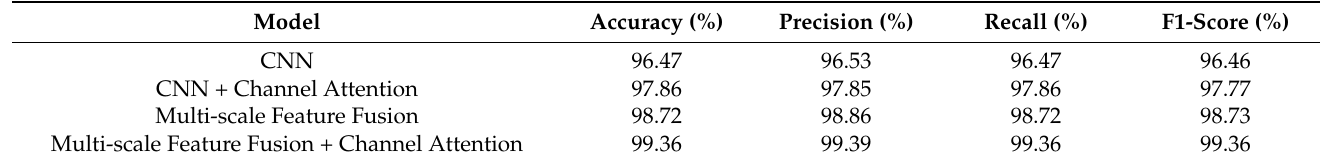
Figure 8. Accuracy, precision, recall, and F1-scores for each model in every malware family. Table 8. Results of ablation